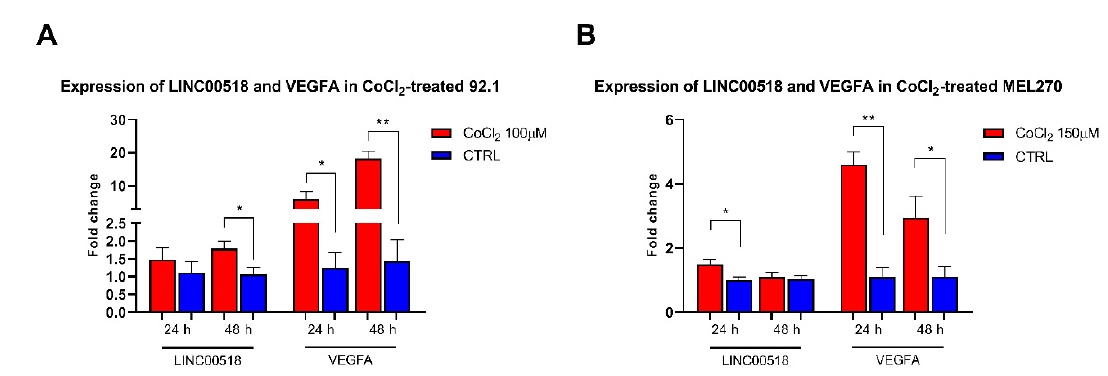
Figure 4 . Expression of VEGFA and LINC00518 after HIF1A activation. ( A ) 92.1 cells treated with CoCl 2 . ( B ) MEL270 cells treated with CoCl 2 . *: p -value < 0.05; **: p -value < 0.0005.